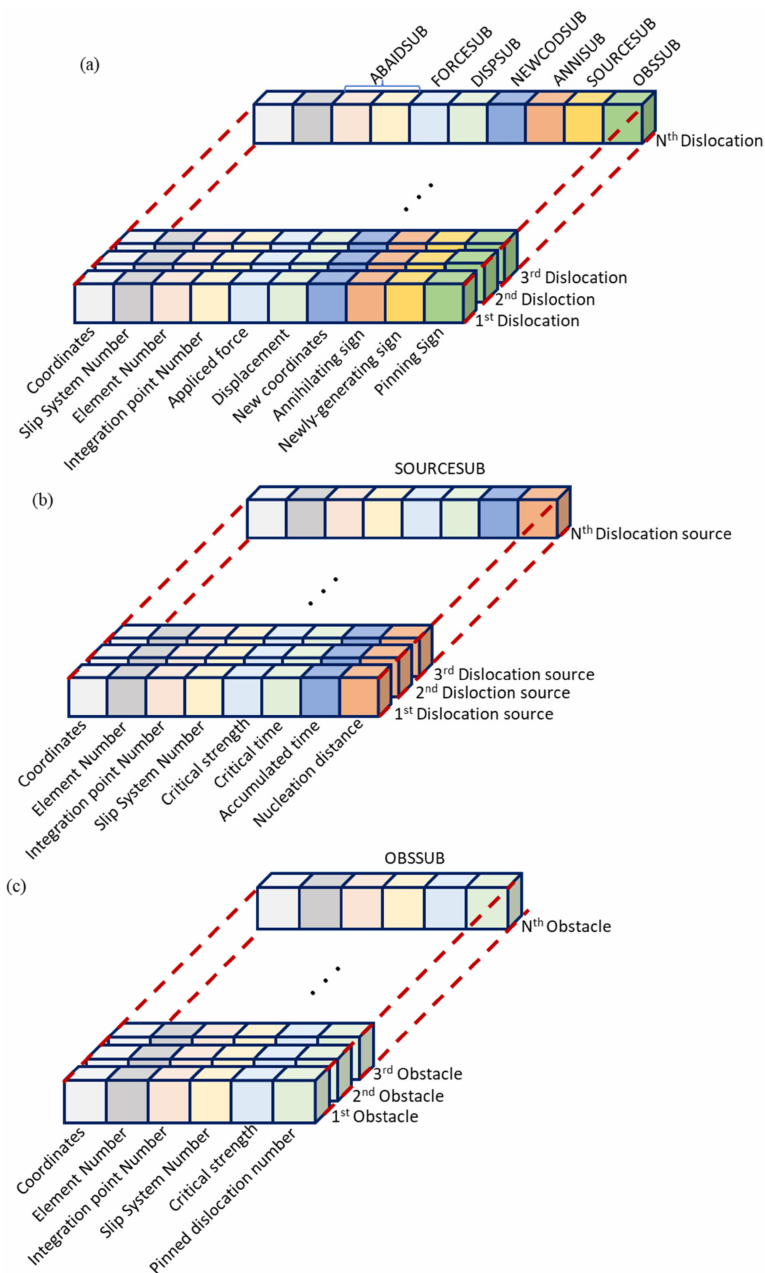
Figure 8. The data structures of dislocations ( a ), obstacles ( b ), and dislocation sources ( c ), and the relative user